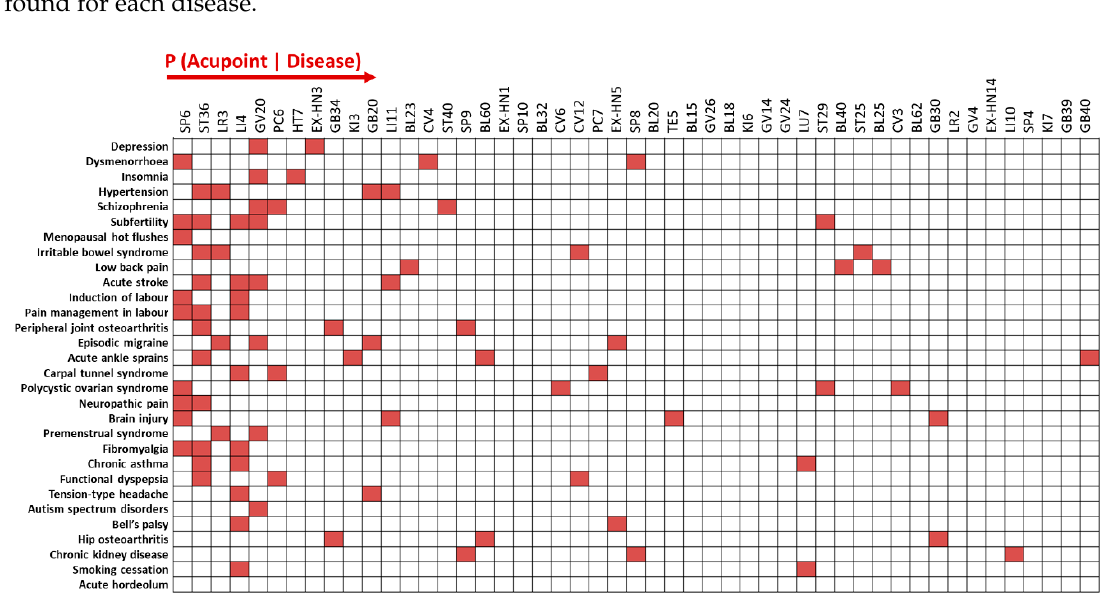
Figure 2. Patterns of acupoint selection for 30 diseases using forward inference. The most frequently selected acupoints were similar across the 30 diseases, while different patterns of selected acupoints were found for each disease. Z-scores indicate the frequency of each acupoint in each disease trial, compared to the overall acupoint selection pattern for that disease.